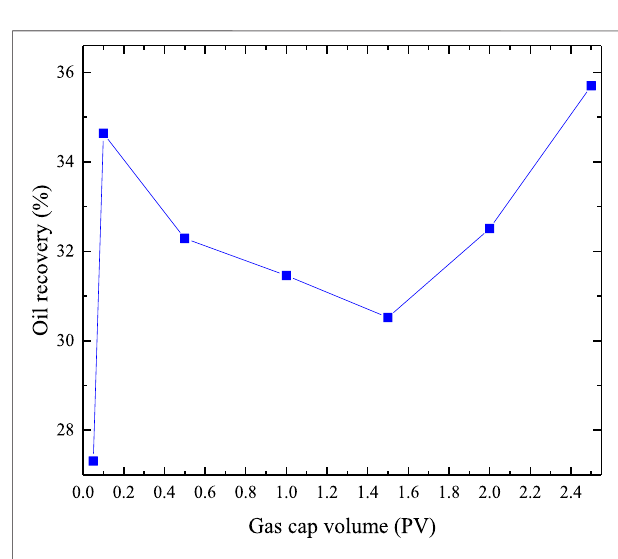
FIGURE 13 | Effect of gas cap on recovery